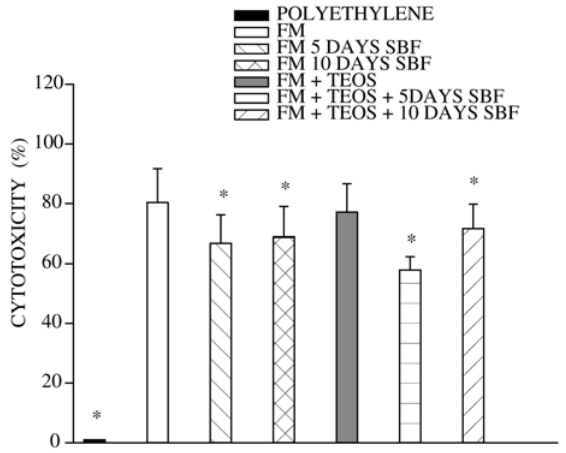
Figure 3. Cytotoxicity of FM ® glass fibers submitted to different treatments. Dotted lines show cytotoxicity of Latex (100%). High Density Polyethylene was used as negative control. Each value is a mean + SEM from 6-9 samples. The fibers (FM®) treated ir bit with tetraethoxysilane (TEOS) were immersed during 5 and 10 days in Simulated Body Fluid (SBF). Statistical analysis: “t” Test by Stu- dent-Mann-Whitney. *Values are significantly different (p < 0.05).